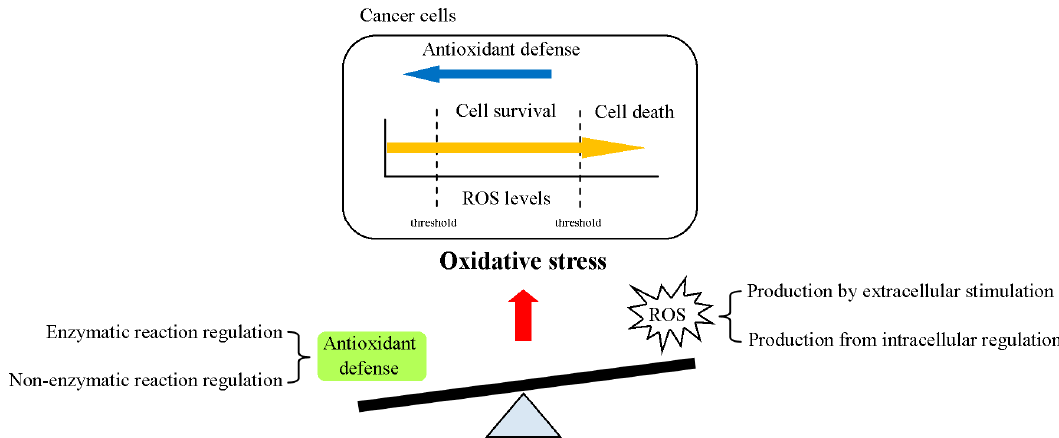
Figure 1. Reactive oxygen species (ROS) production and antioxidant defense in the control of redox homeostasis in cancer cells. Disruption of redox homeostasis by ROS (intra- or extracellular signals) and antioxidant defense (enzymatic or non-enzymatic reactions) induces oxidative stress (OS) and results in various cell functions. The physiological function of ROS is dependent on its concentration. Elevated ROS production and accumulation lead to cell apoptosis. On the other hand, medium levels of ROS promote cell survival and progression.